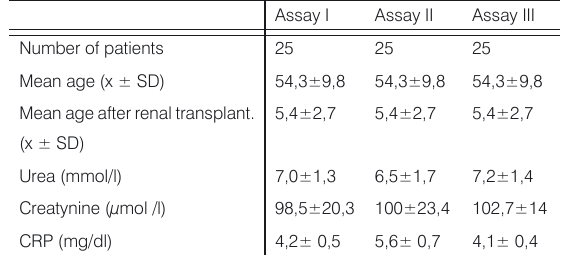
Table 1. The clinical characteristics of patients.